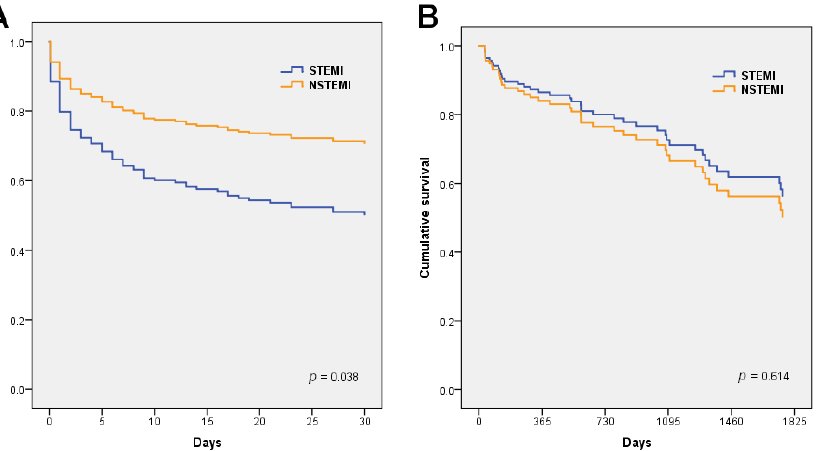
Figure 2. Cox-adjusted survival curves according to ST-segment presentation. ( A ) All-cause death in the first 30 days; ( B ) All-cause death from 30 days to 5